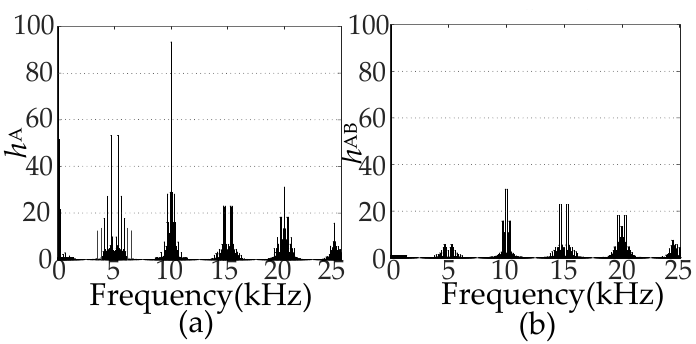
Figure 4. Theoretical spectral of output voltage ( m = 0.5, f c = 5 kHz, f in = 50 Hz, f out = 70 Hz) ( a ) spectrum of u A ( b ) spectrum of u AB .